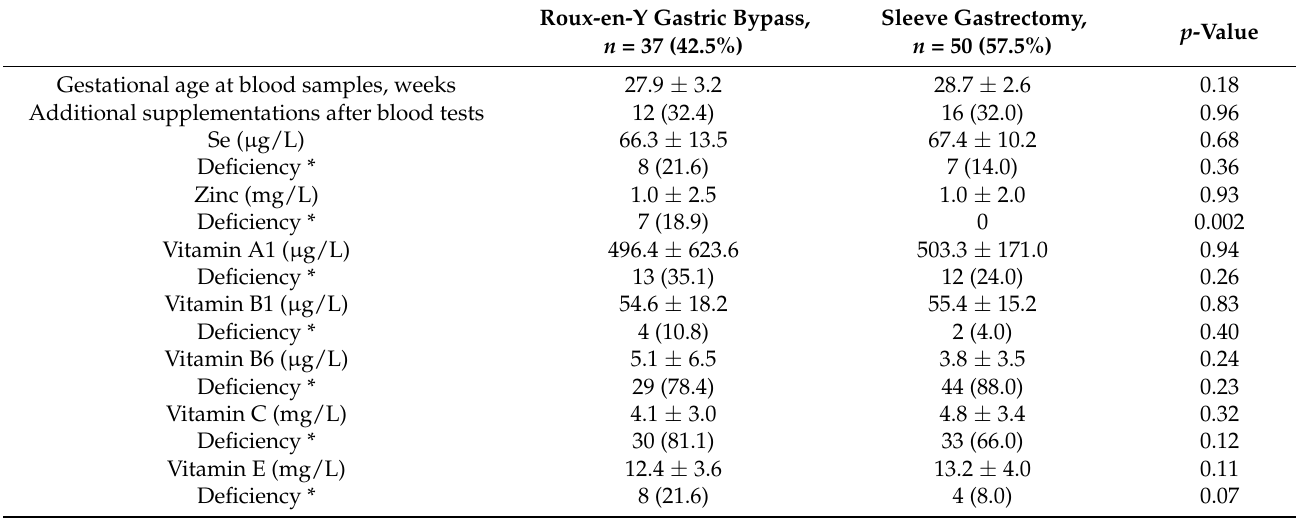
Table 2. Micronutrients values and deficiencies according to the type of bariatric surgery. Roux-en-Y Gastric Bypass, Sleeve Gastrectomy, n = 37 (42.5%) n = 50 (57.5%)